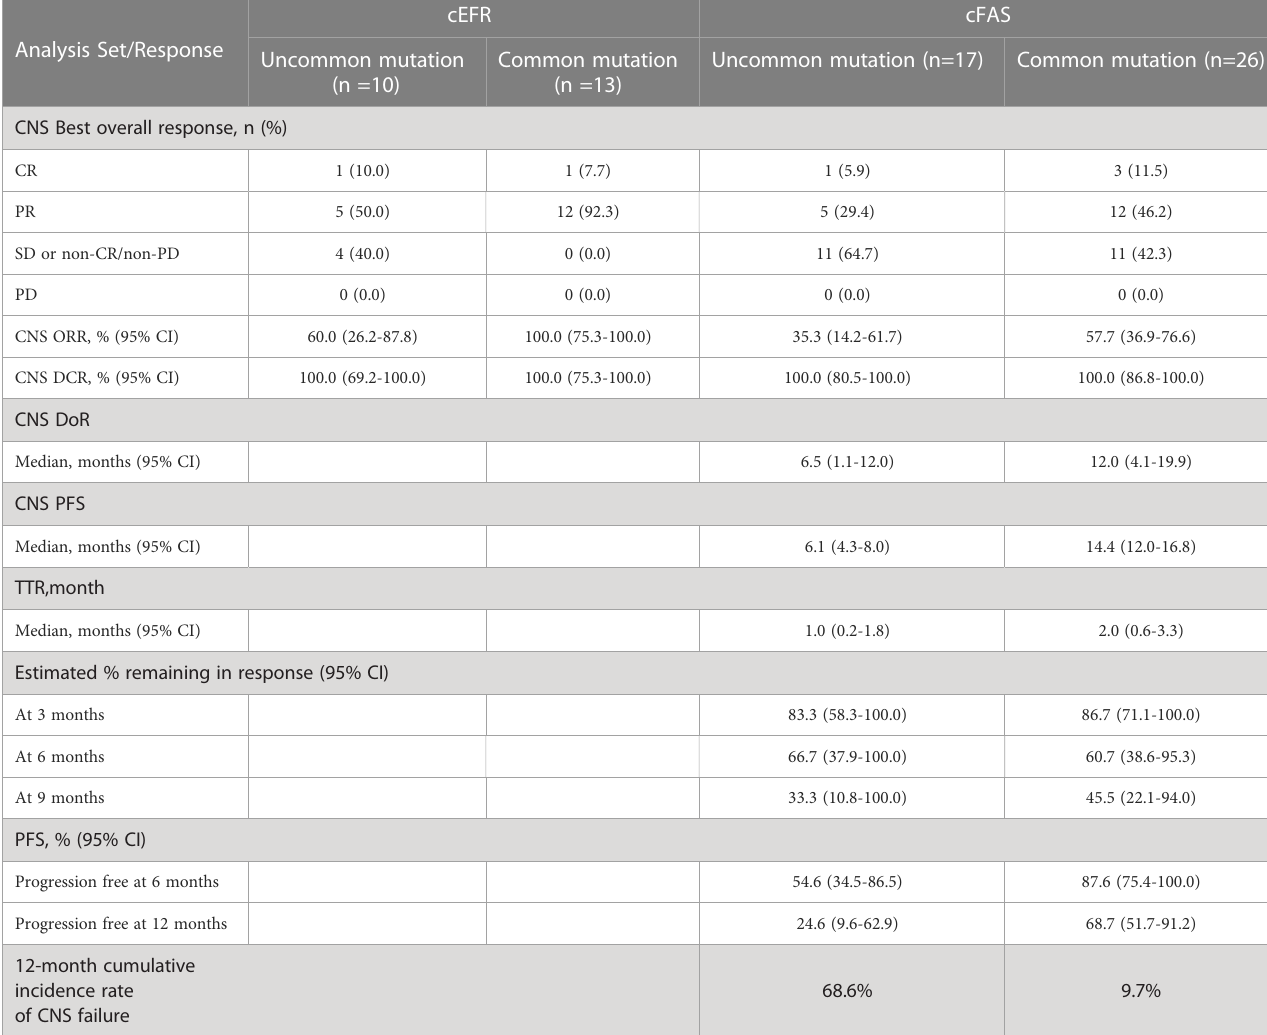
TABLE 3 CNS activity of afatinib in patients harboring common mutations or uncommon mutations.